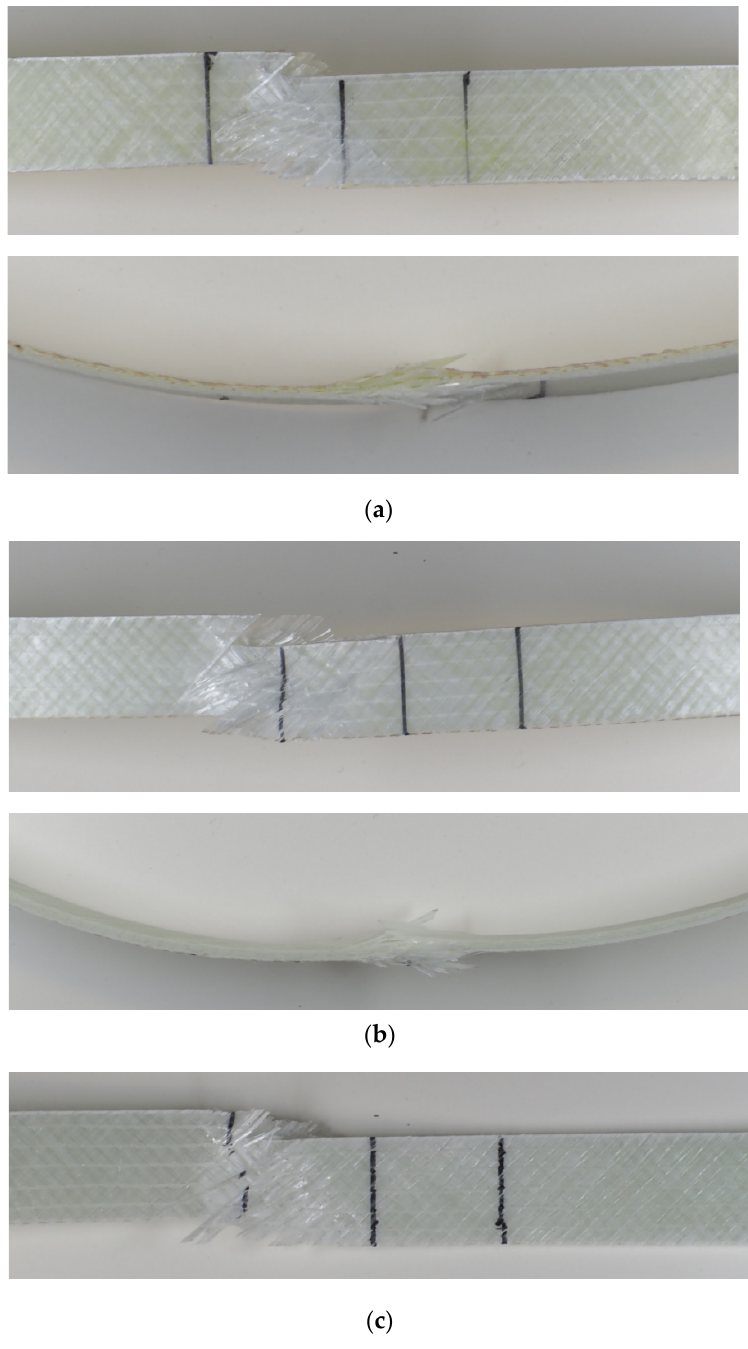
Figure 5. Locations of failure for some samples: ( a ) V1, vacuum repair with hand layup, ( b ) HL, hand layup lamination, ( c ) UV1, handheld UV curing. layup lamination, ( c ) UV1, handheld UV